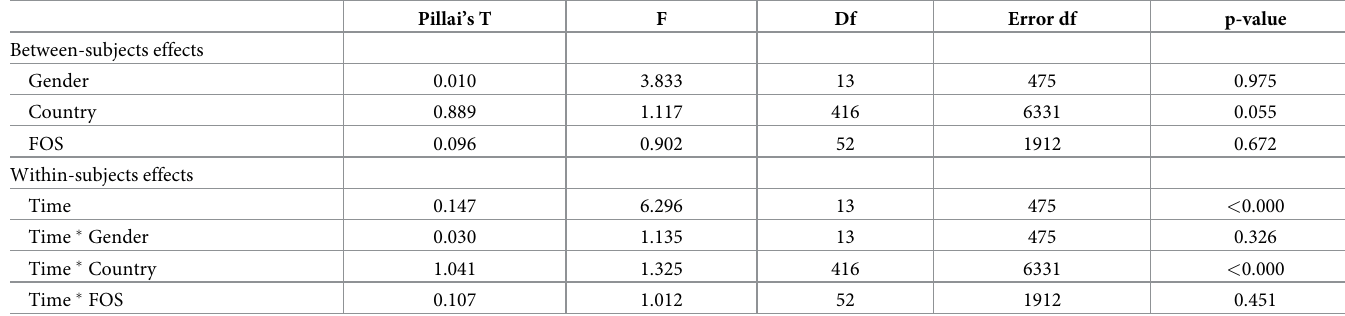
Table 2. Multivariate tests for the pre-pandemic versus first pandemic semester comparison.